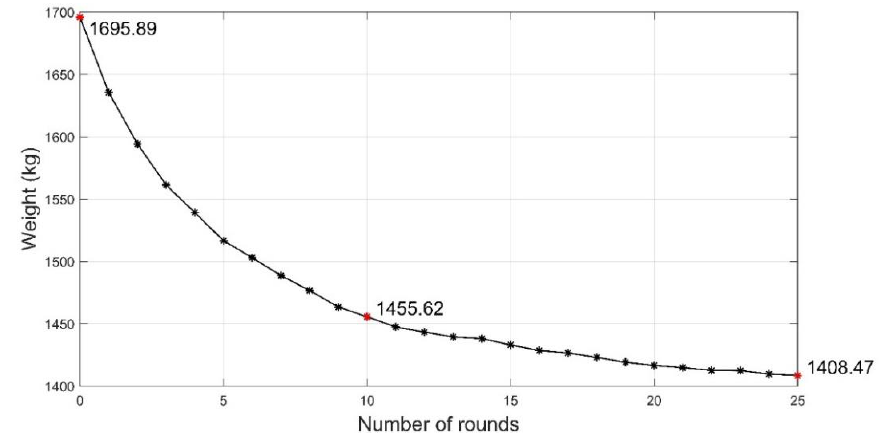
Figure 6. Weights of the structure after all rounds of refinement in stage II.